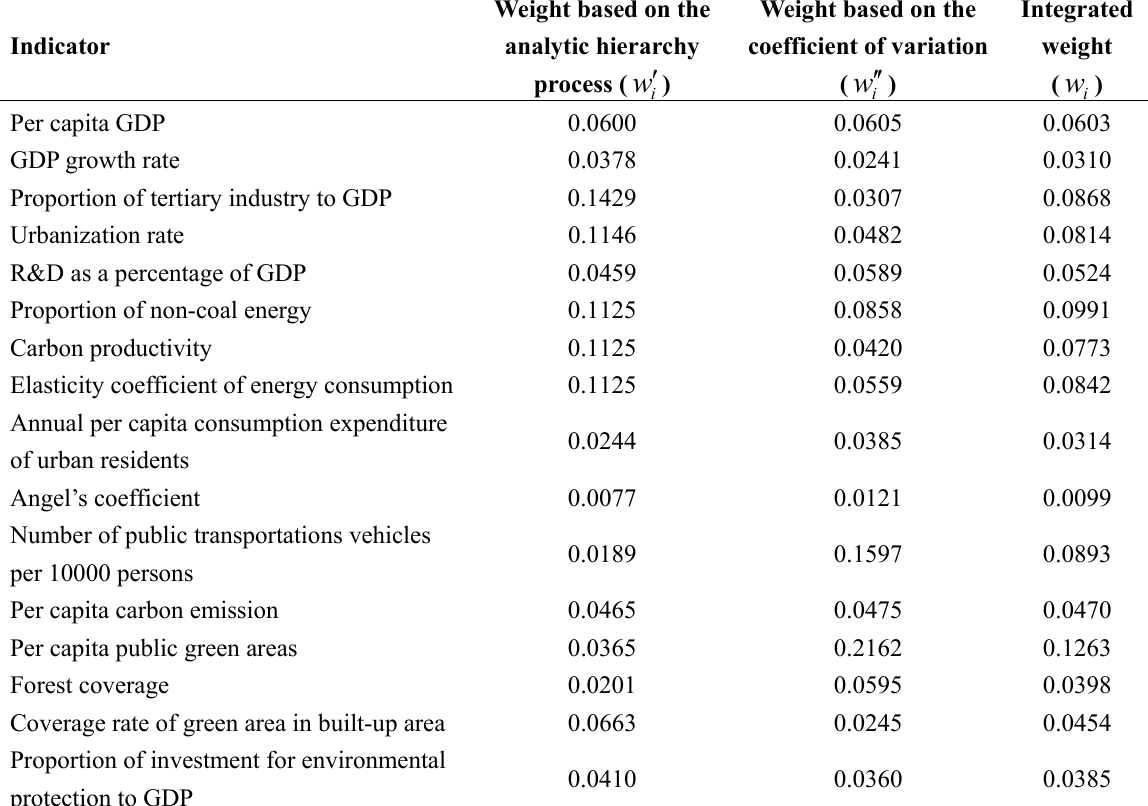
Table 2. Indicator weight of urban low-carbon development